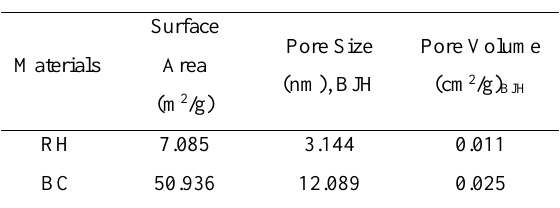
Fig. 3. FTIR spectrum of RH (a) and BC (b)